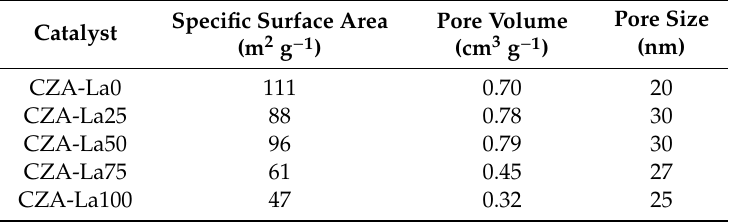
Table 1. Textural properties of the synthesized CuO / ZnO / Al 2 O 3 (CZA)-La x